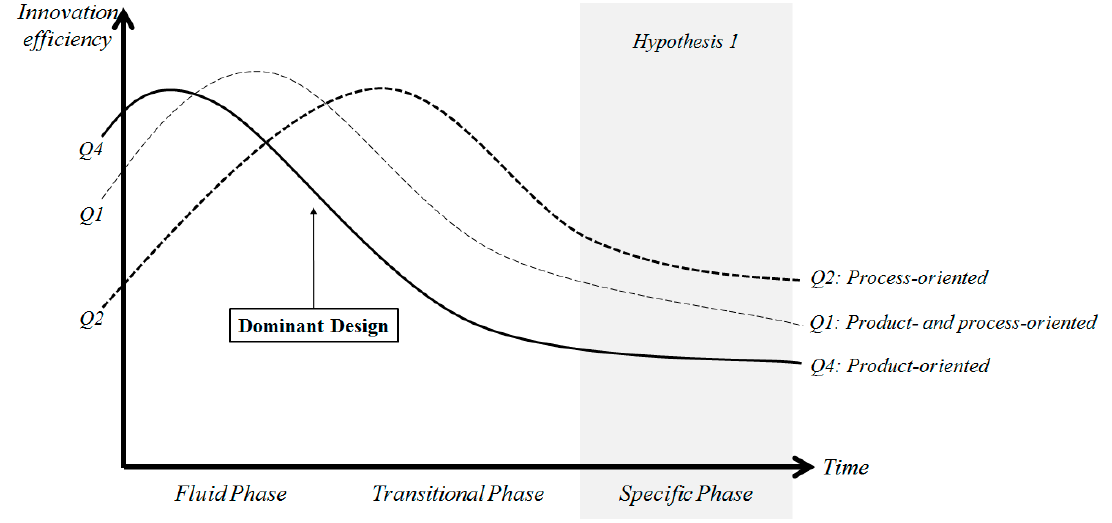
Figure 5. Hypothesis supported by the result.